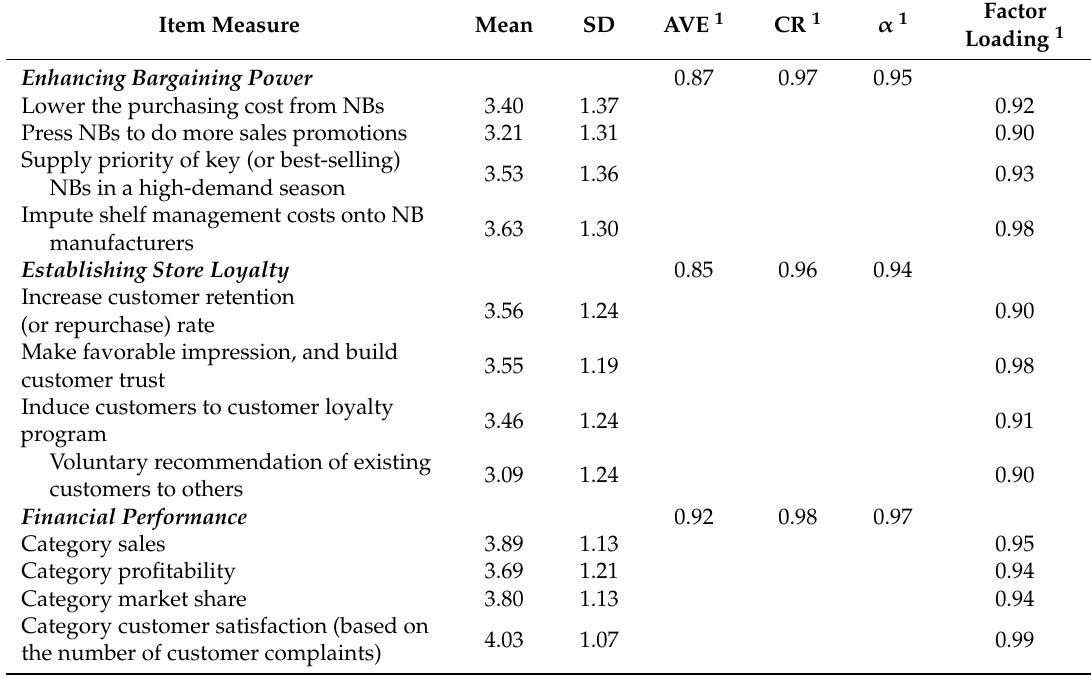
Table 1. Properties of measurement model for reflective